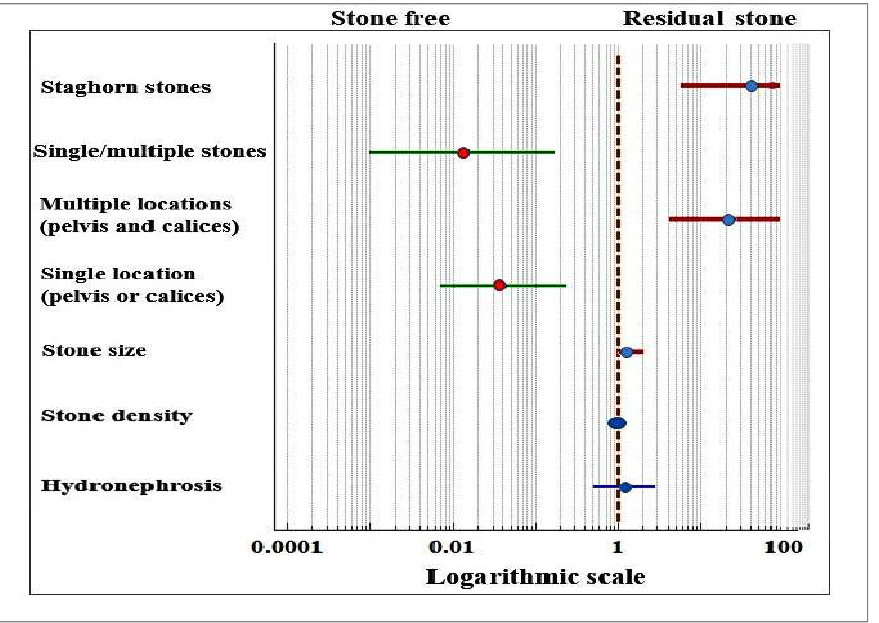
Figure 4. Forest plot of the odds ratios and 95% confidence intervals of the variables associated with stone-free rate and residual stone.